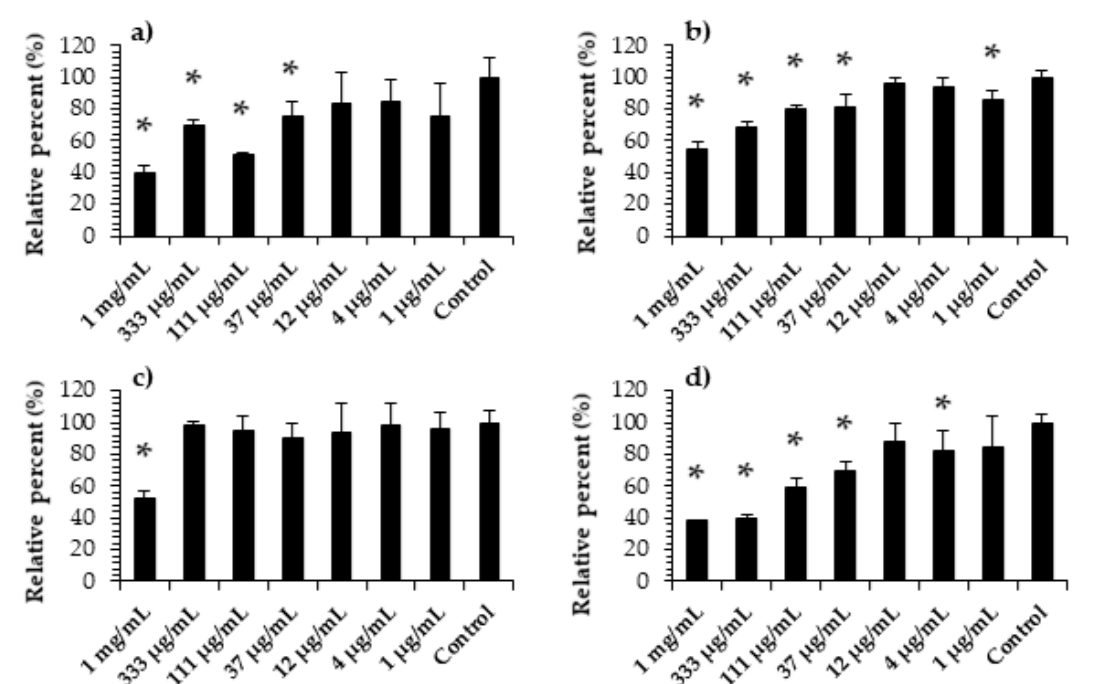
Figure 1. Viability of exposed normal CLAB cells. ( a ) Tanex; ( b ) Farmatan; ( c ) Contan; ( d ) gallic acid. Results presented as mean absorbance/fluorescence values ± standard deviations of independent triplicates expressed as percentage relative to control. * represents statistically significant differences between concentrations and control within the studied HT at p ≤ 0.05.